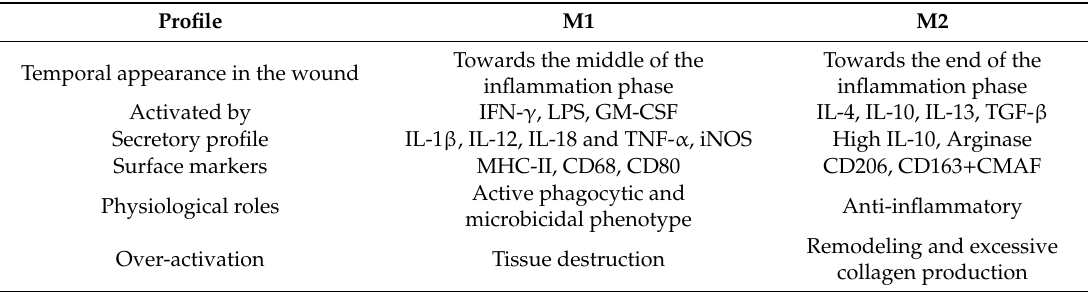
Table 1. Di ff erence between M1 and M2